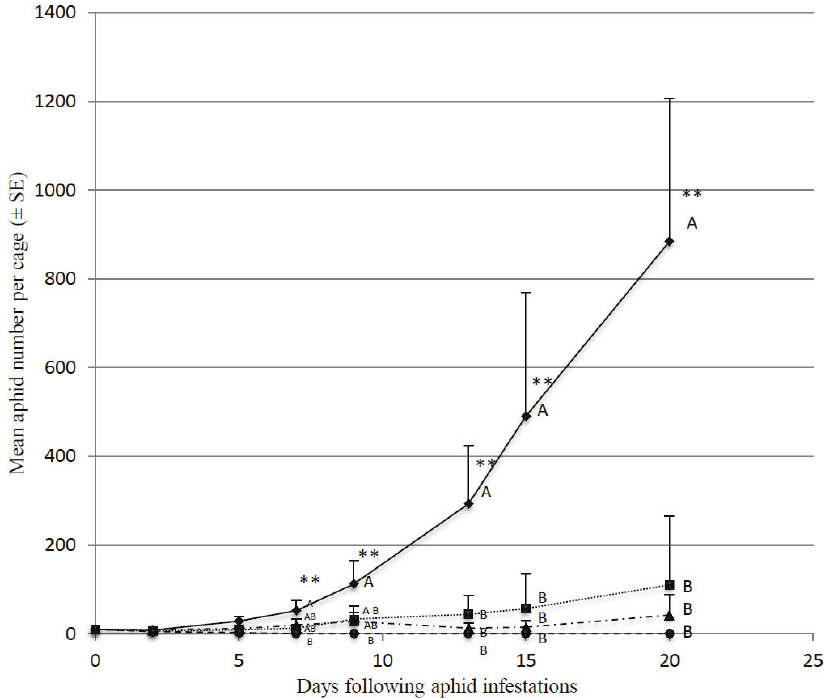
Figure 1. Evolution of mean aphid number in cages ( n = 4) containing four sweet pepper, in presence of different M. pygmaeus densities (0, plain line with diamond shapped dots; 16 per cage, dotted line with square dots; 32 per cage, dashed and dotted line with triangle dots and 48 per cage, dashed line with circle dots).*, stars indicate mean aphid number statistically differing with M. pygmaeus density, aphid number sharing the same letter can not be considered as different.